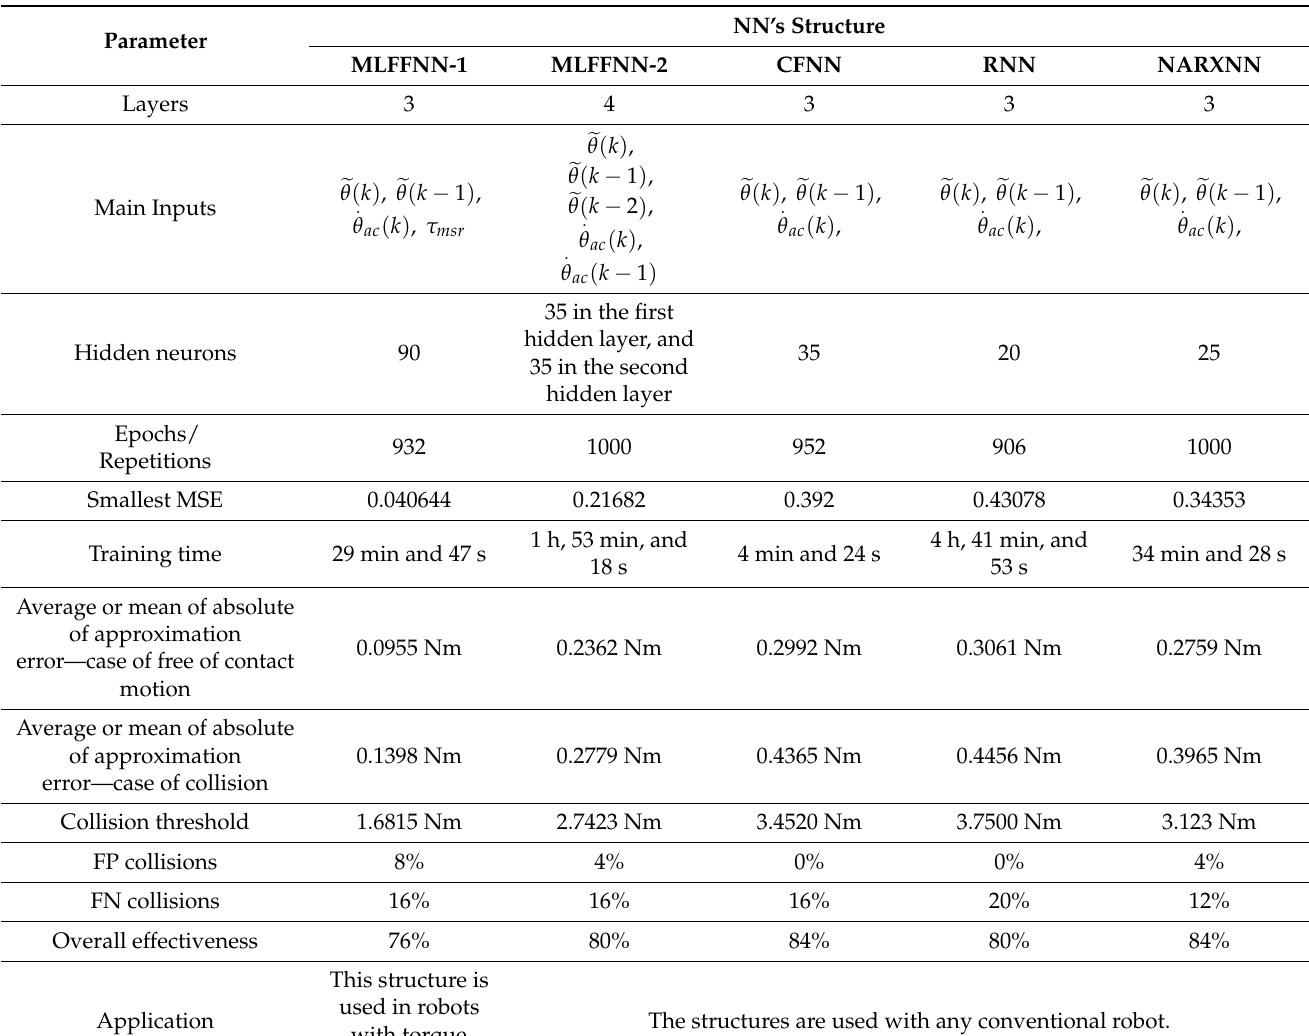
Table 3. The comparison between the developed NN structures (MLFFNN-1, MLFFNN-2, RNN, CFNN, NARXNN) for human–manipulator collision